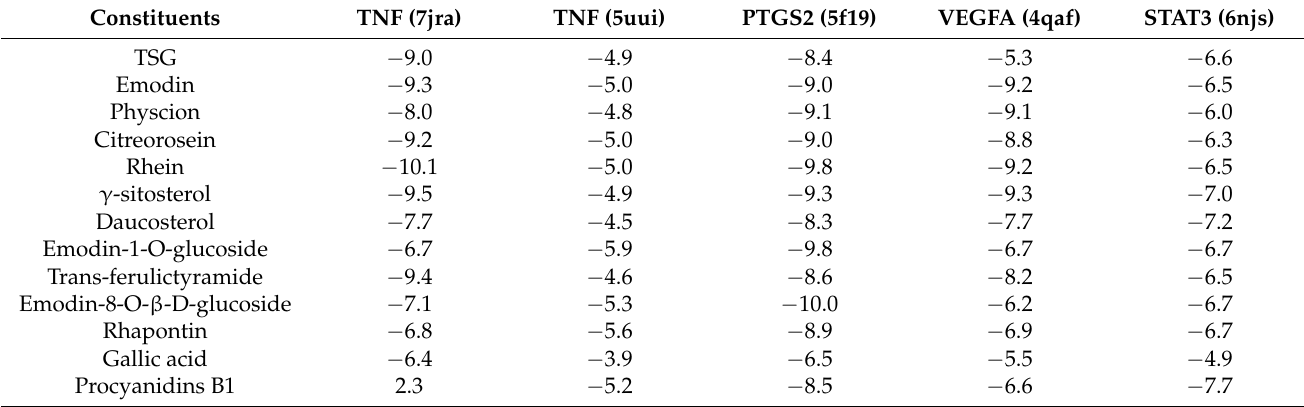
Table 5. Binding activity of active constituents docked to target